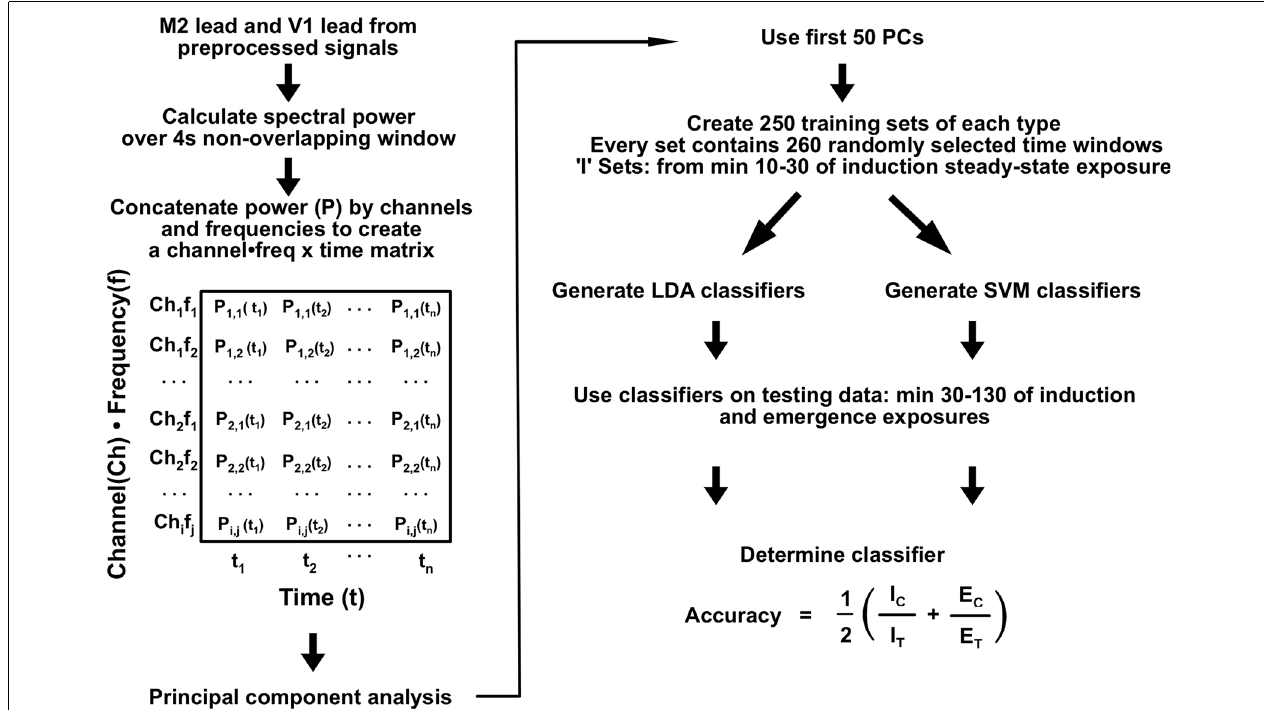
FIGURE 3 | EEG analysis process